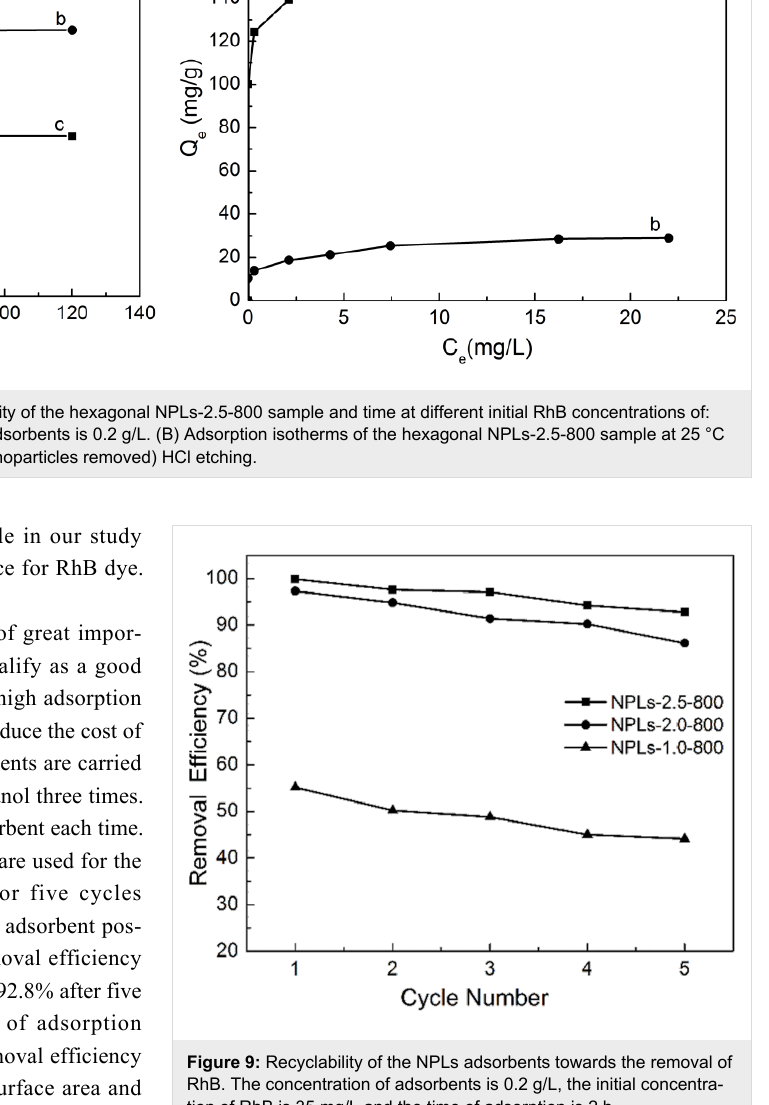
Figure 9: Recyclability of the NPLs adsorbents towards the removal of RhB. The concentration of adsorbents is 0.2 g/L, the initial concentra- tion of RhB is 35 mg/L and the time of adsorption is 2